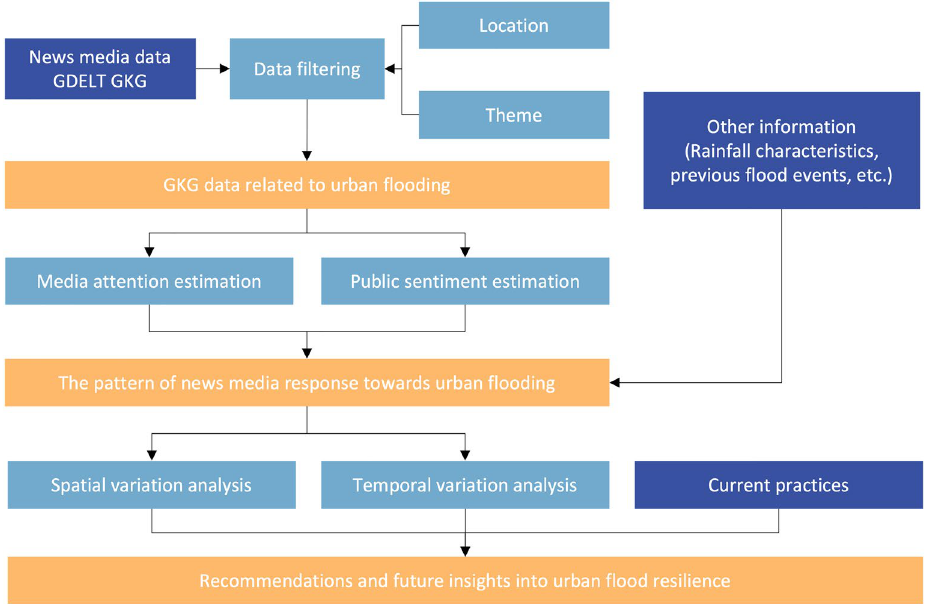
Figure 8. Research